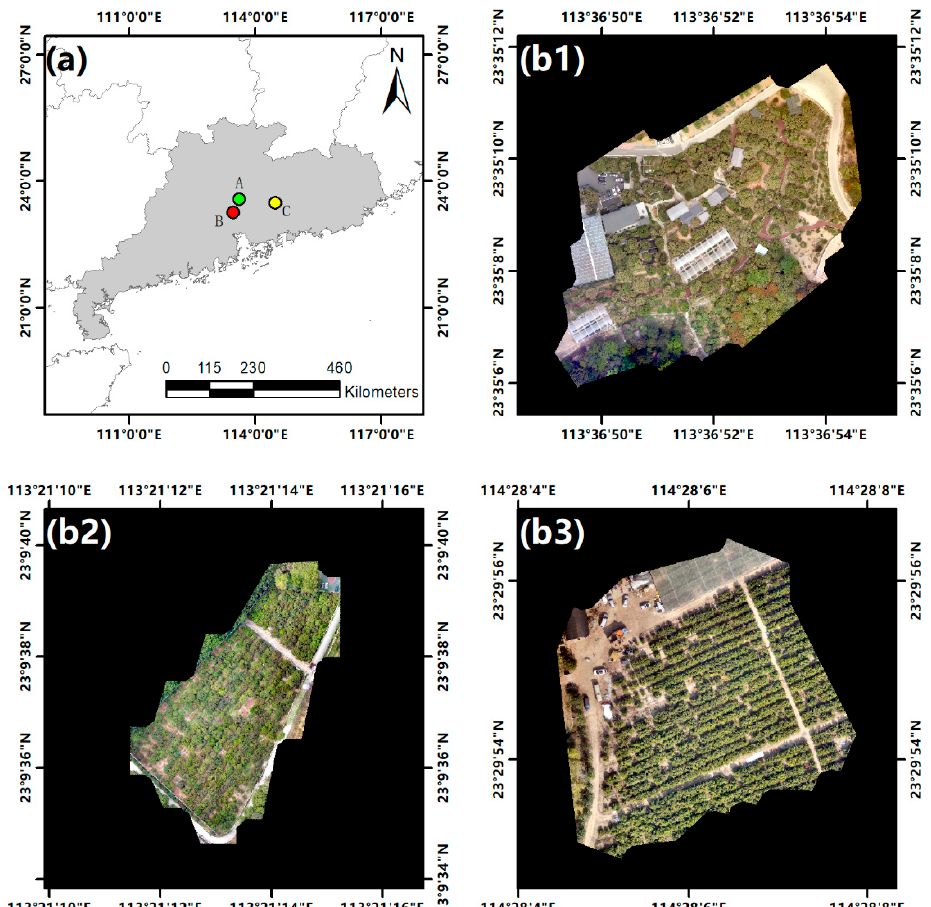
Figure 1. Overview of the study areas. ( a ) The locations of the study areas. ( b1 – b3 ) digital ortho- photo maps of Areas A, B, and C acquired by a UAV, respectively.